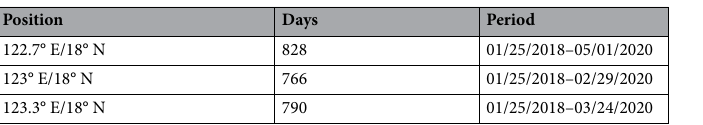
Table 1. Positions, total days, and corresponding periods for the ADCPs during mooring